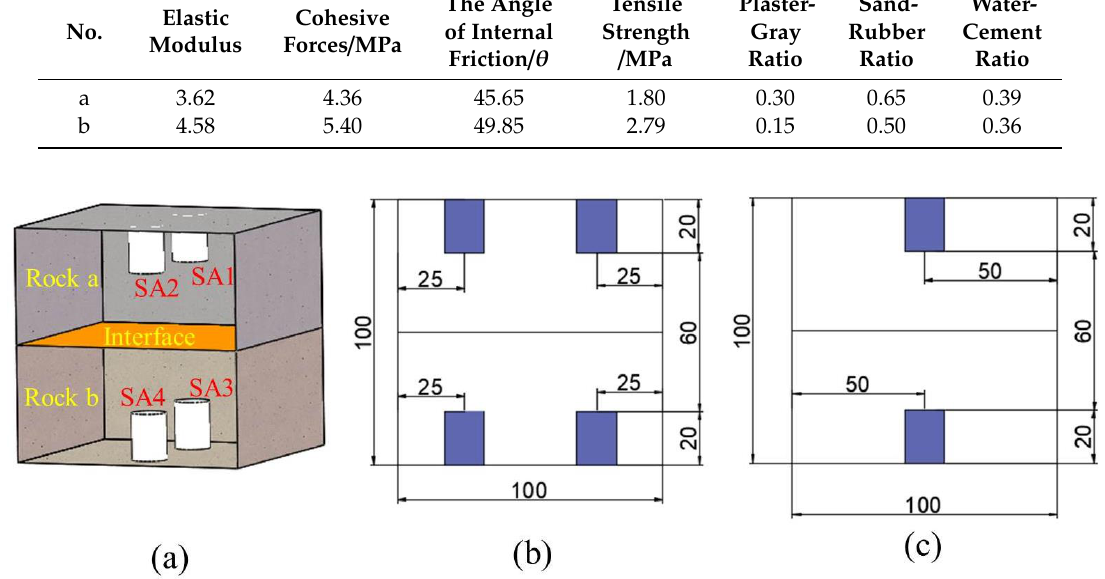
Figure 4. Three-dimensional schematic of specimen and specific size drawing: ( a ) Three-dimensional diagram and ( b ) Front-view and ( c ) Side-view drawings (units: mm).